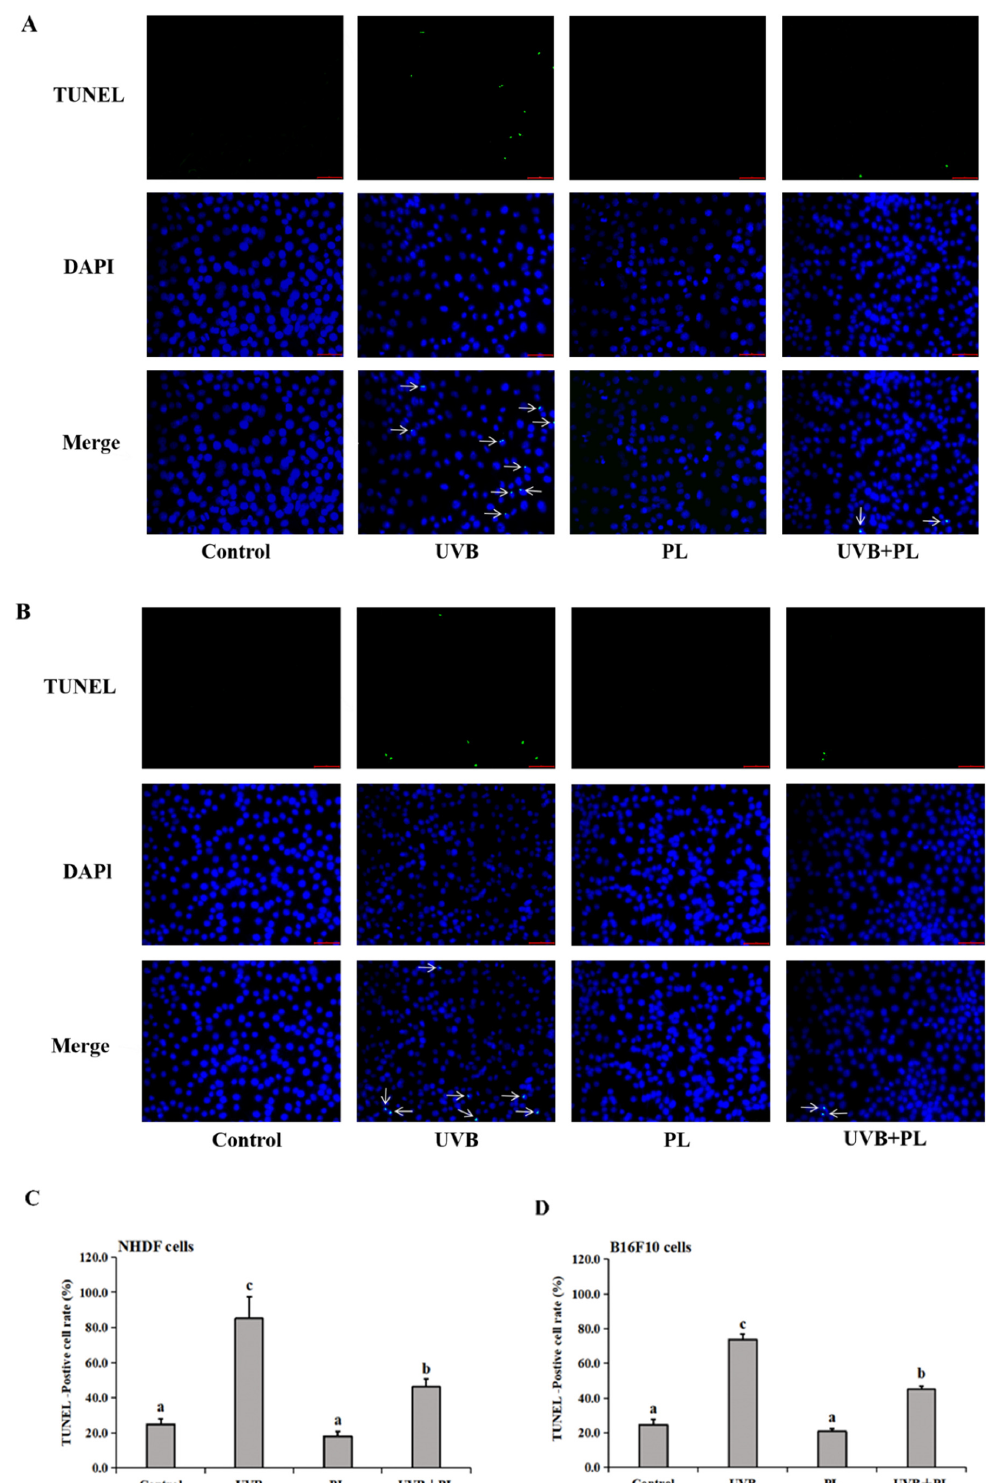
Figure 2. Effects of PL on DNA damage by TUNEL assay in NHDF cells ( A ) and B16F10 cells ( B ). White arrows mark green fluorescence. Quantitative analysis of TUNEL-positive cell rate in NHDF cells ( C ) and B16F10 cells ( D ). Results are expressed as the mean ± SD ( n = 3). Differences among the variables were assessed using Duncan’s multiple range tests. Values having different letters are significantly different ( p <